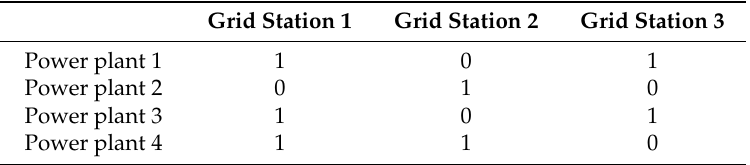
Table 6. Optimal values of binary variables for the first part of the supply chain.